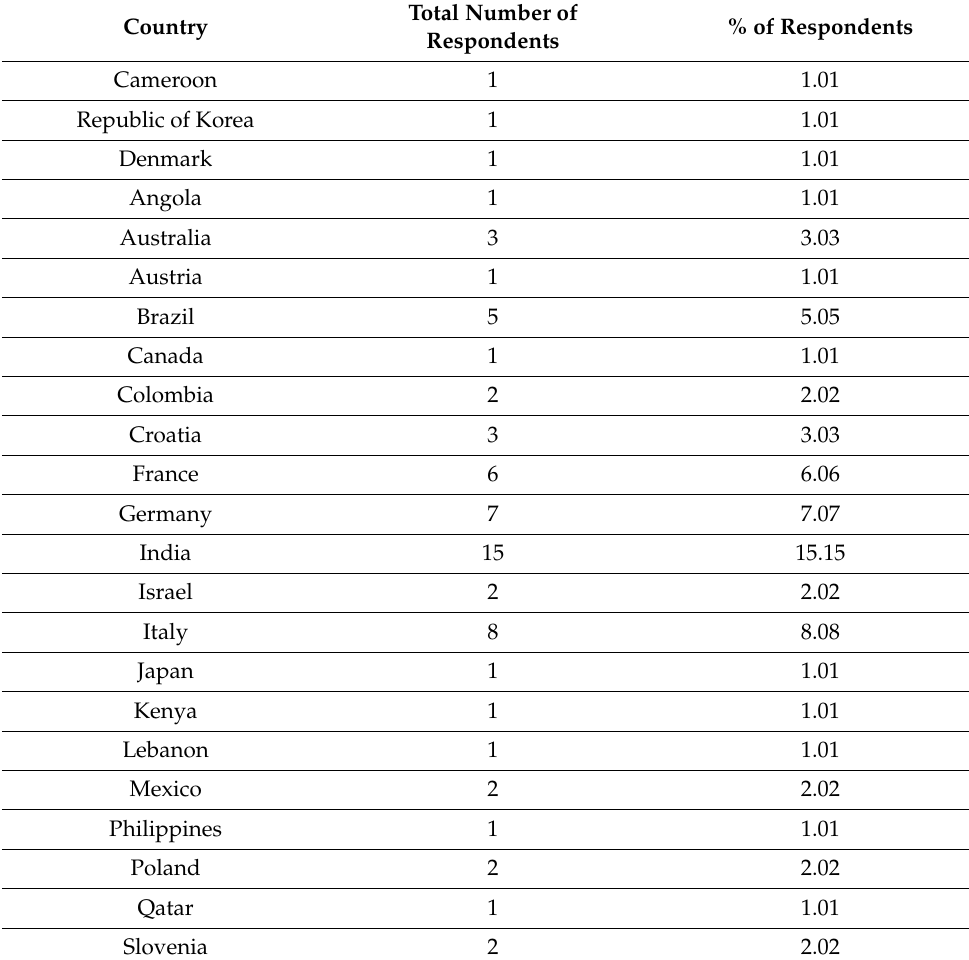
Table A3. Total number of countries and respondents involved in the